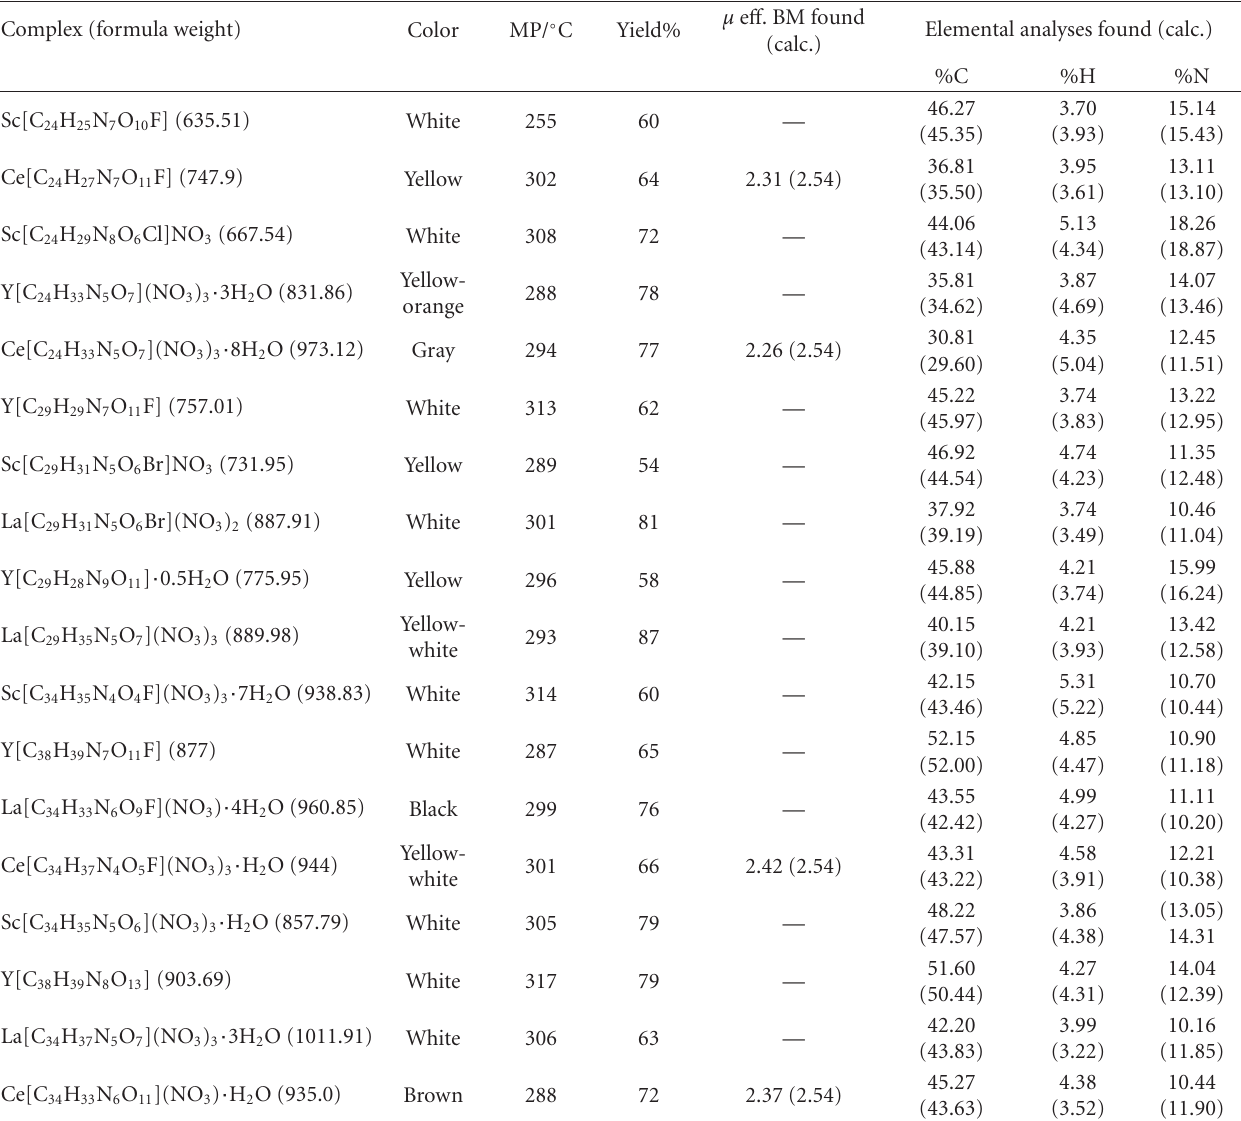
Table 5: Physical properties, magnetic moments, and elemental analyses of